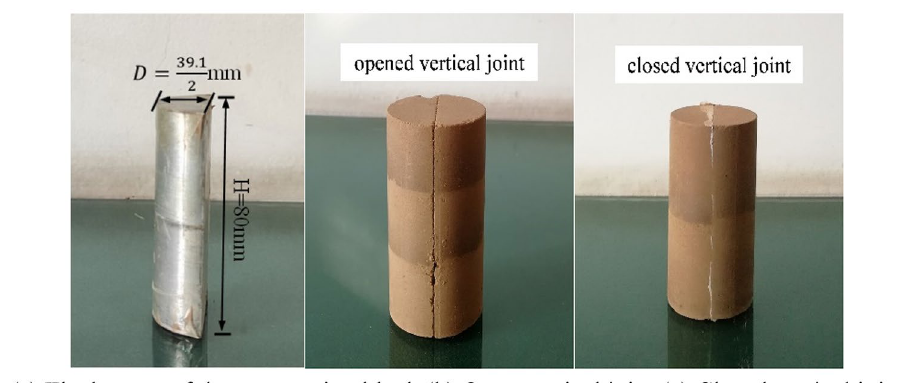
Figure 2. Two kinds of vertical joint samples with different bonding